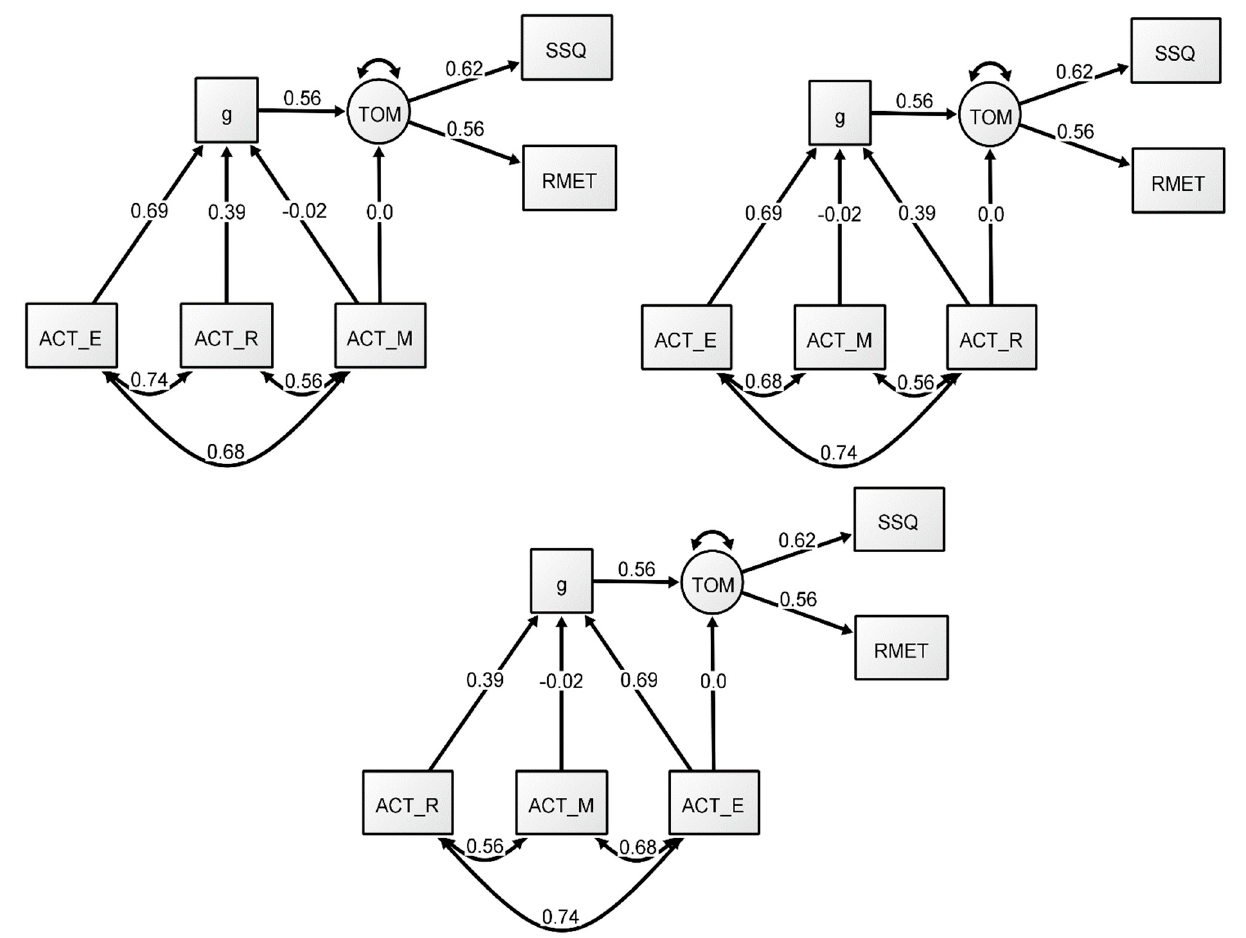
Figure 3. Formative- g SEM models with additional paths. All coefficients presented are standardized.